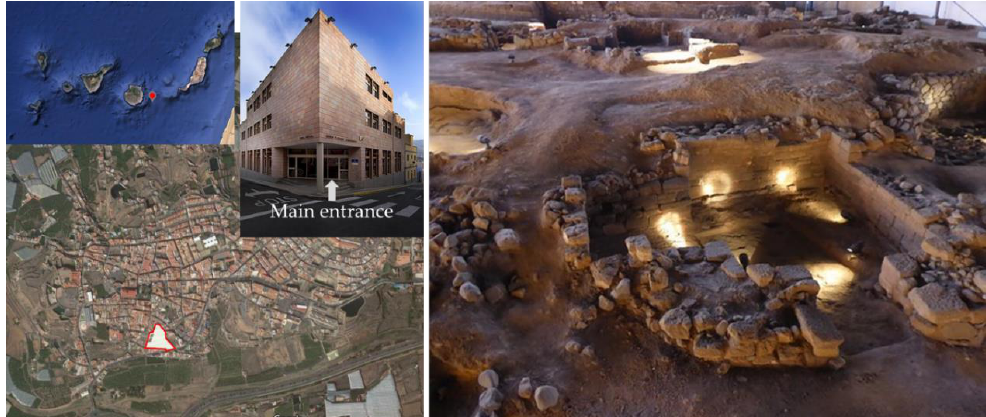
Figure 6. Geographic location of the “Cueva Pintada” archaeological site (Left) and a detailed image of a remains of houses (Right). a remains of houses